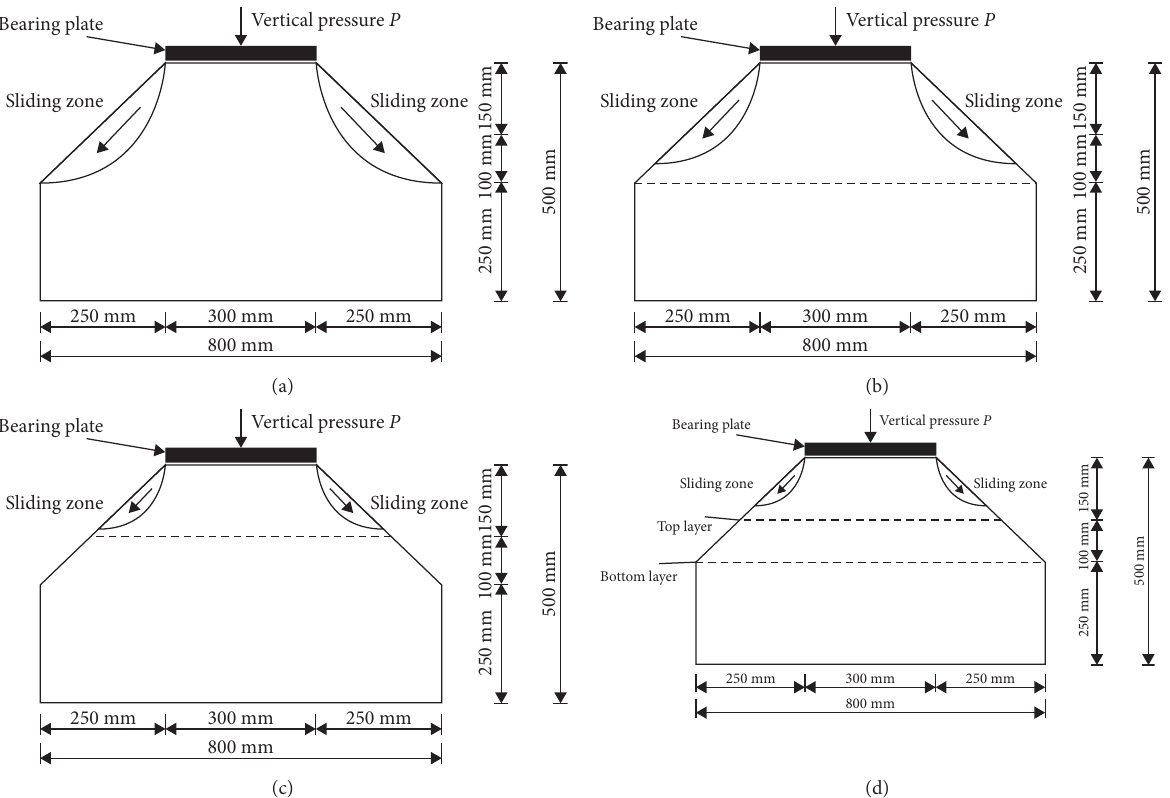
Figure 12: Failure model diagram of trapezoidal filling structure. (a) Failure model of pure concrete granular trapezoidal filling structure. (b) Failure model of bottom layer reinforced trapezoidal filling structure. (c) Failure model of top layer reinforced trapezoidal filling structure. (d) Failure model of two layers reinforced trapezoidal filling